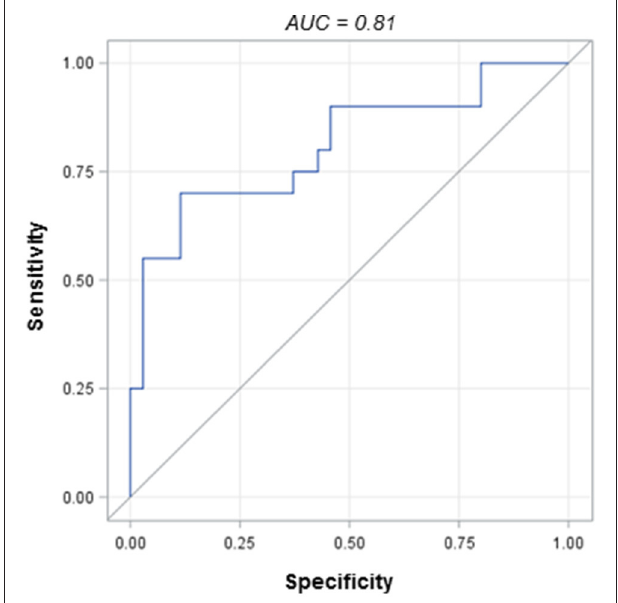
FIGURE 2 | Receiver operating characteristic (ROC) curve for the cytokine panel in CAA vs. hypertensive ICH patients.